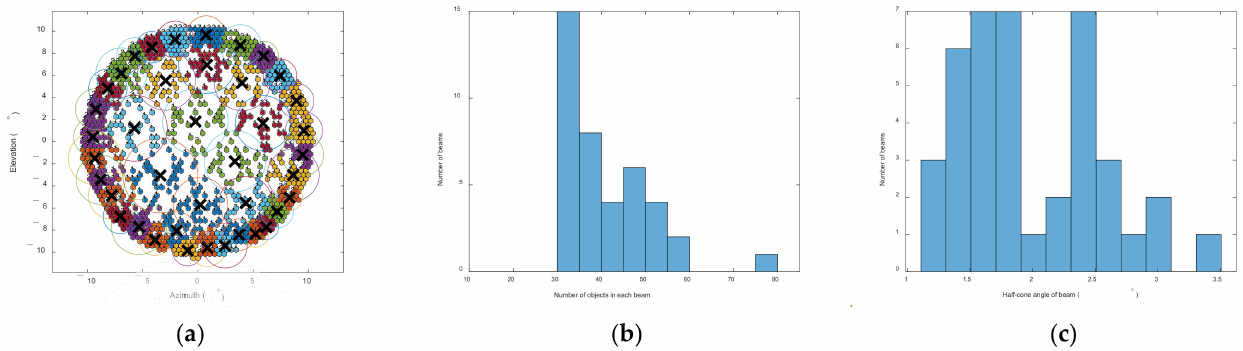
Figure 11. Optimization results of the beam allocation based on the modified K-means clustering when parameter α equals 0.5 and β equals 0.8: ( a ) Plot of the allocated 40 beams. The crossing indicates the geometrical center of each beam. The neighboring hexagonal cells in the same beam are marked with the same color; ( b ) Statistics of the beam occupation; ( c ) Statistics of the beam